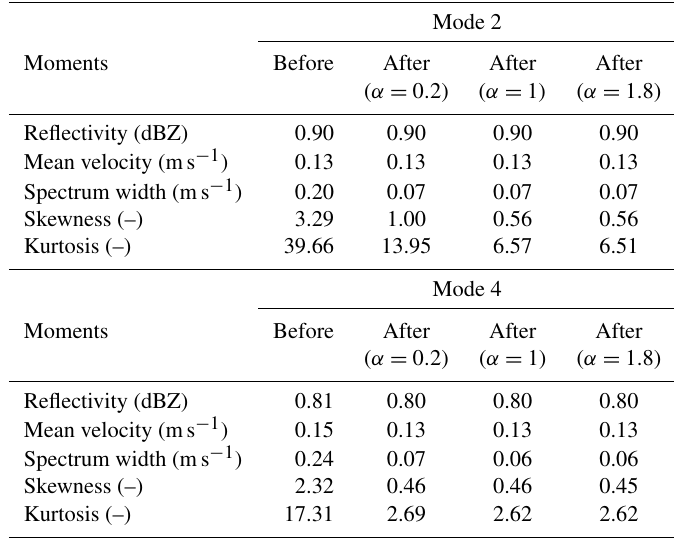
Table B2. Standard deviation (SD) for Ka-band spectral moments before and after the sidelobe removal compared with observations at mode 3. Radar observations from 4.5 to 6km are used for comparison.